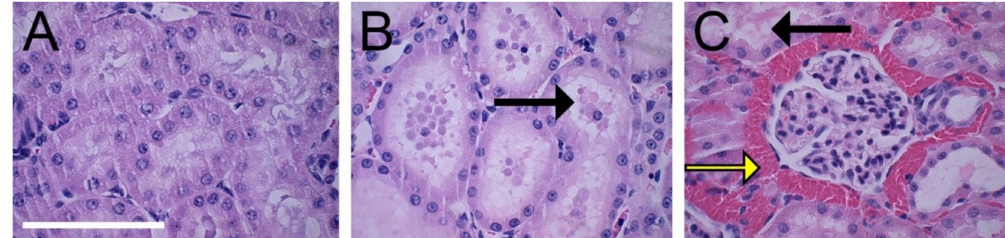
Figure 6. Hematoxylin and eosin staining of the renal cortex from three rats. ( A ) Control. ( B ) After renal artery clamping. ( C ) After renal vein clamping. The black arrows show intratubular cast formation in the tubules. The yellow arrow shows erythrocytes accumulated in the renal interstitial space around a glomerulus. Scale bar: 100 µ